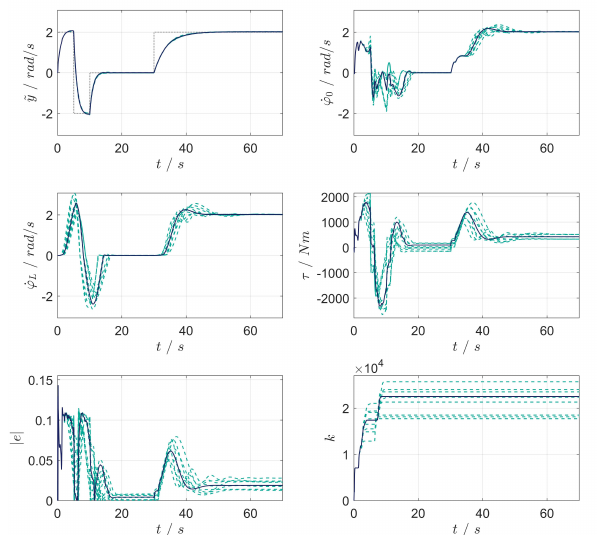
Figure 16. Transient responses of the closed-loop system. Adaptation and angular velocity reference tracking in presence of parameter uncertainties: nominal parameter model (solid blue) and uncertain parameter model (dashed